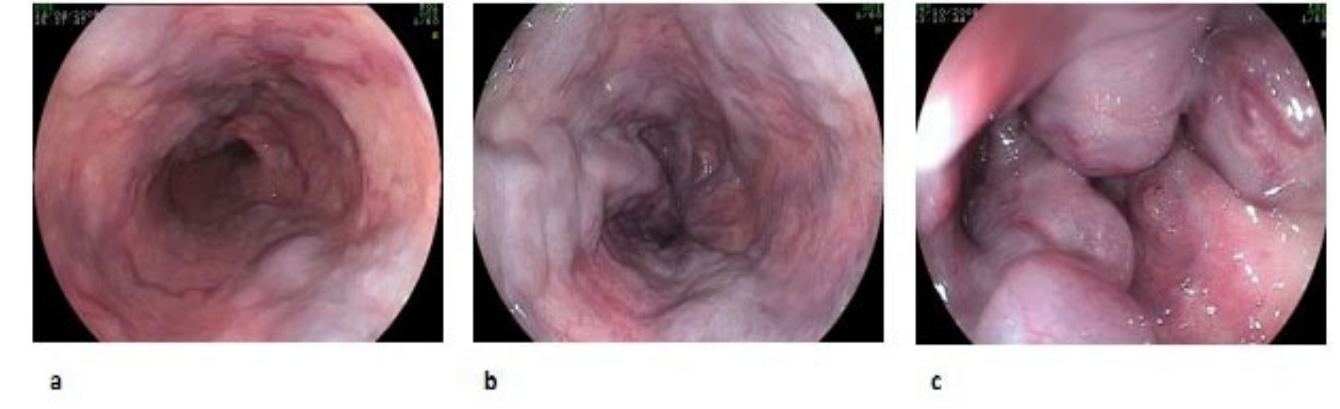
Figure 1. Esophageal varices according to size: F1 ( a ), F2 ( b ), F3 ( c ).